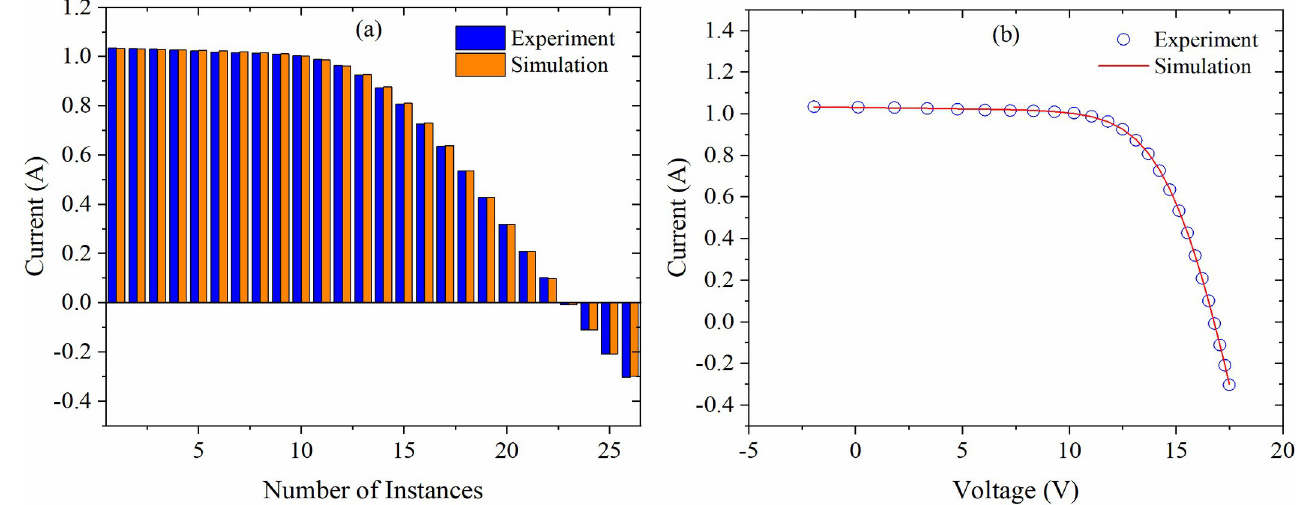
Fig 4. Simulated and experimental currents for single-diode model of Photowatt-PWP201 solar module (a) and their I-V curves (b).